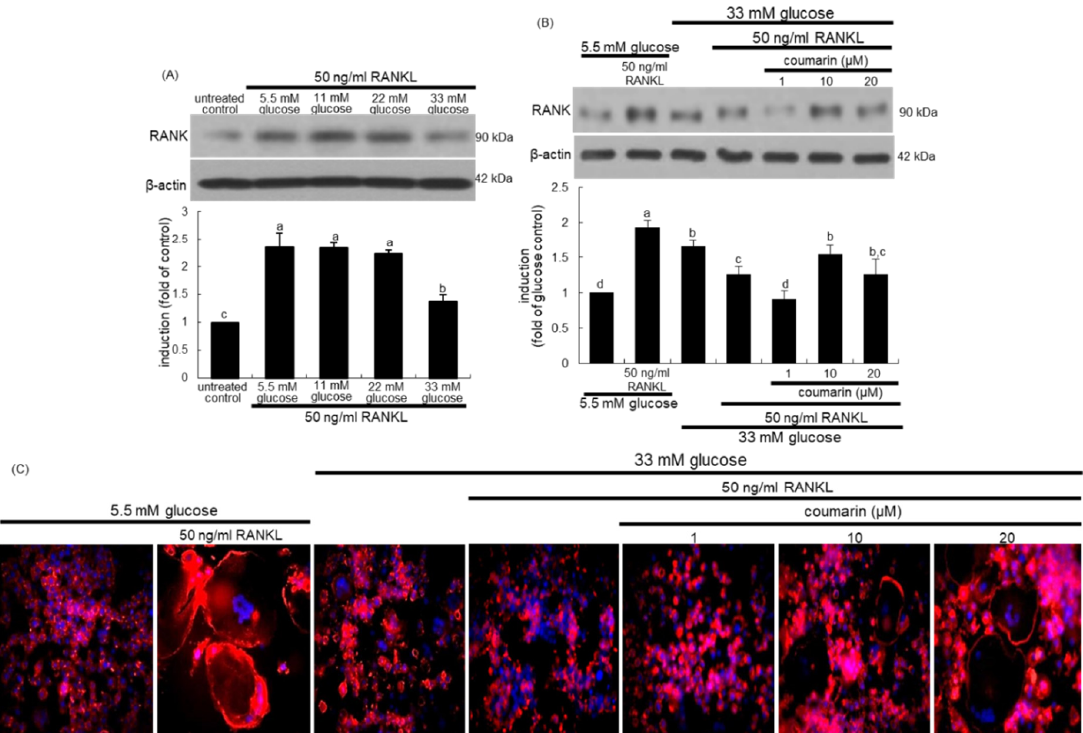
Figure 2. Receptor activator of NF ‐ kappa B (RANK) induction by various concentrations of glucose ( A ), elevation of RANK induction ( B ), and osteoclast actin ring formation ( C ) by coumarin in glucose and RANKL ‐ exposed Raw 264.7 cells. RAW 264.7 cells were cultured in α‐ MEM containing 5.5 mM glucose or 11 ‐ 33 mM glucose in the absence and presence of 50 ng/mL RANKL or 1–20 μ M coumarin for five days. The RANK induction was measured by western blot analysis using cell lysates with a primary RANK antibody ( A , B ). β‐ Actin protein was used as an internal control. Representative blots shown are typical of three independent experiments. The bar graphs (mean ± SEM) in the bottom panel represent quantitative results obtained from a densitometer. Values not sharing a letter are different at p < 0.05. RANKL ‐ differentiated cells were fixed, and rhodamine phalloidin was added to fixed cells ( C ). Fluorescent images were taken with a fluorescence microscope. Original magnification of microscopic images ( n = 3), 40 ‐ fold.